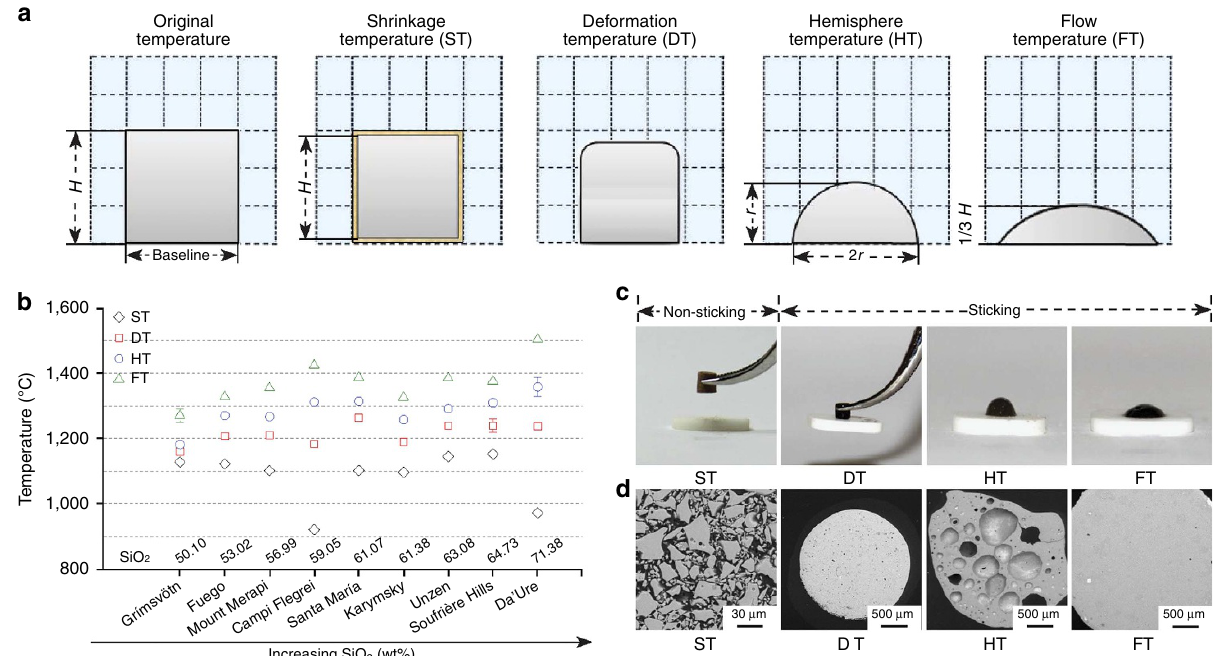
Figure 2 | Geometric characterization of volcanic ash compacts at the characteristic temperatures. ( a ) Geometrical definition of four characteristic temperatures (ST, DT, HT and FT) in the volcanic ash melting process (see Methods and ref. 12). Each dotted box equates to an area of 1mm (cid:3) 1mm. ( b ) Distribution of the four characteristic temperatures for the nine volcanic ash, ordered as a function of SiO 2 content. Each data point represents the mean value of two independent measurements; the s.d.’s are illustrated and generally found to be smaller than the symbol. ( c ) Typical behaviour observed during a test, here with Grı´msvo¨tn’s volcanic ash, along with ( d ) back-scattered electron images of corresponding microstructures of the volcanic ash at the four characteristic